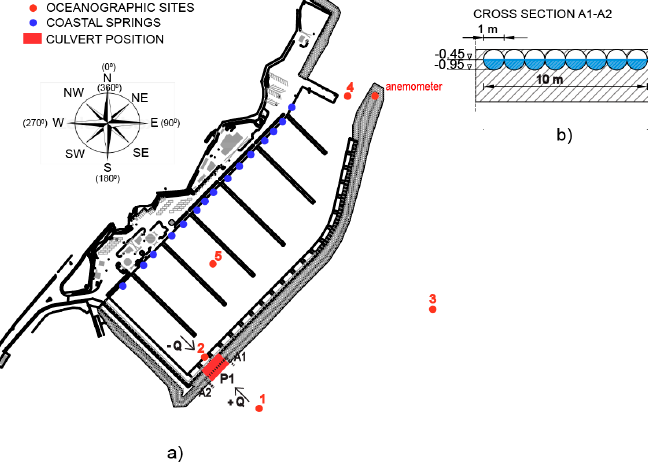
Figure 3. ( a ) Plan view of the oceanographic sites in the marina (ADCP 1–5—sea current and surface elevation measurements, ADCP 1, 2—wave parameters measurements, 2—PCM and CTD device, 1–5 vertical temperature and salinity profile), the coastal spring positions, the culvert position P1 and; ( b ) cross sections through the flushing